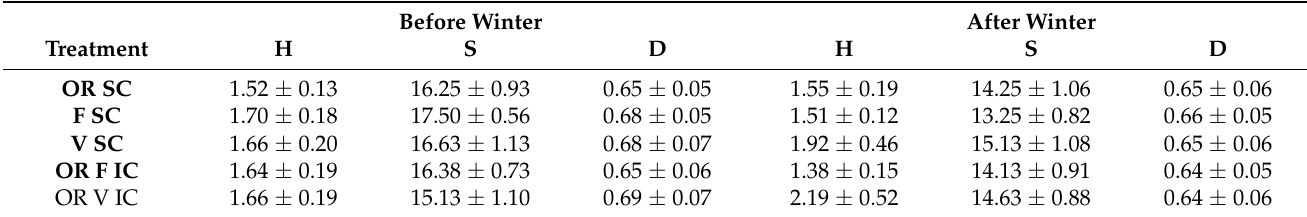
Table 5. The Shannon–Wiener index (H), species richness (S) and the Simpson evenness index (D) corresponding to the treatments of oilseed rape (OR), faba bean (F) and common vetch (V) grown as sole crops (SC) or as intercrops (IC) carried out using the means ( n = 8) ± standard error in 2013/14 and 2015/16.